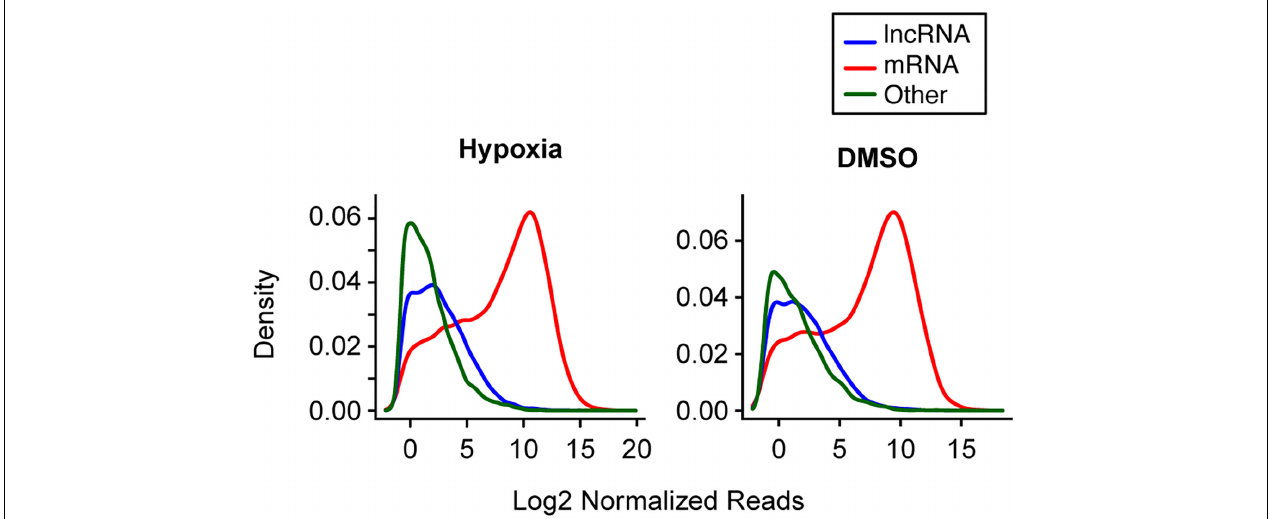
FIGURE 2 | The distribution of selected long RNA reads in PHT cells in the two experimental sets. The X -axis represents the average log2 normalized reads per library, and the Y -axis represents the estimated probability density. Note that analysis of multiple small RNA species was not performed, as the sequencing procedure was designed to enrich for miRNA (which represented 72.3% of small RNAs in hypoxia and 68.8% of RNAs in